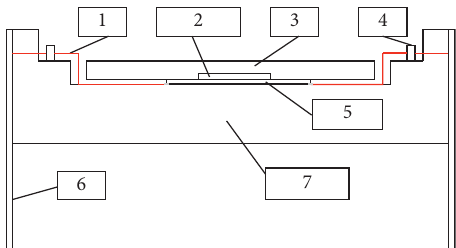
Figure 1: Schematic diagram of the package structure profile. (1) Lead; (2) energetic material; (3) chip; (4) tube base; (5) ignition bridge; (6) pin; (7) ceramic package